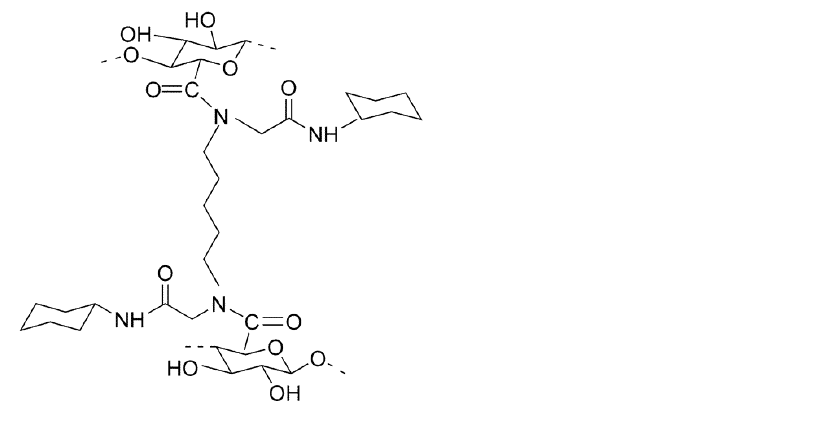
Figure 4. The crosslinking formation by Ugi multicomponent reaction for alginate [71] .